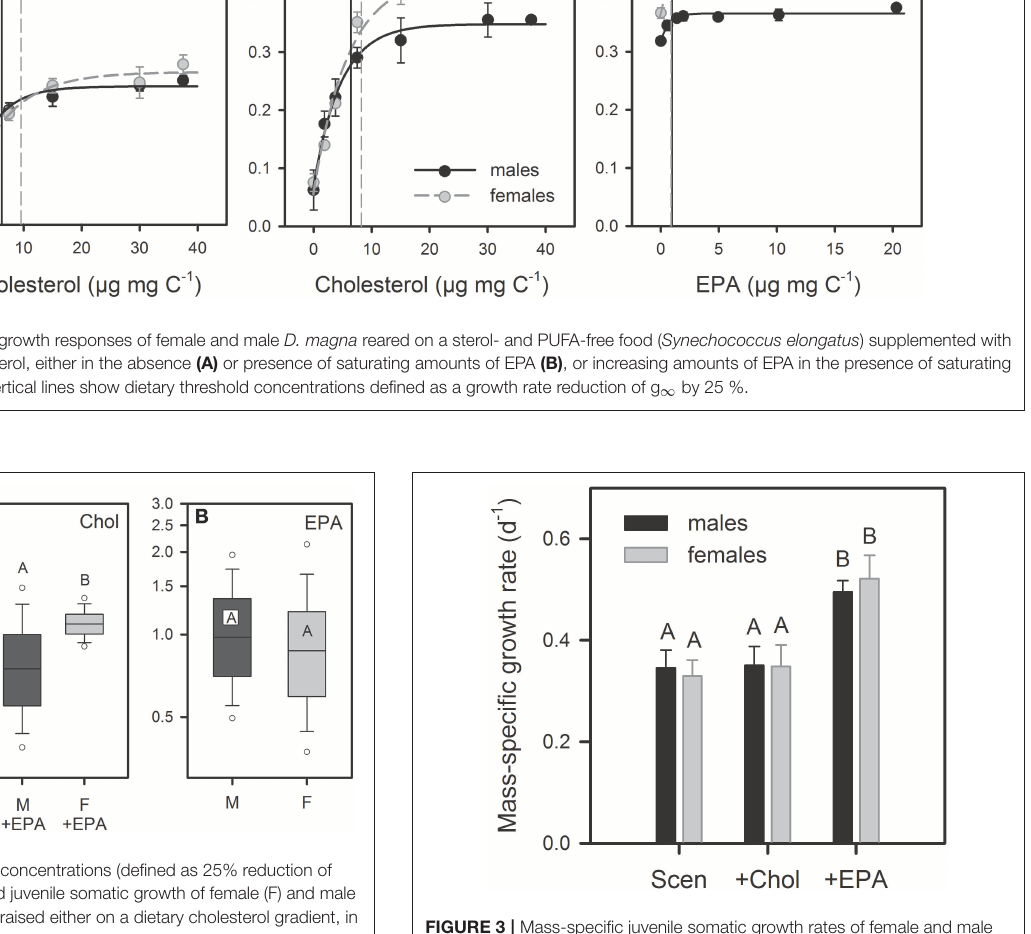
rates on the EPA-supplemented diet (Tukey’s HSD, P < 0.05; Figure